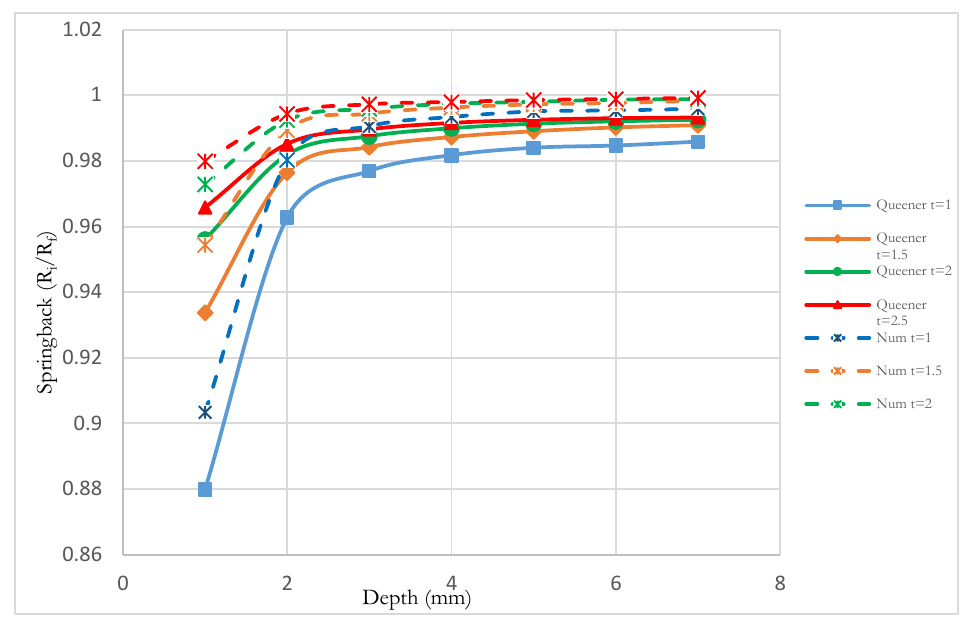
Fig. 14. The evolution of analytical and numerical springback as a function of